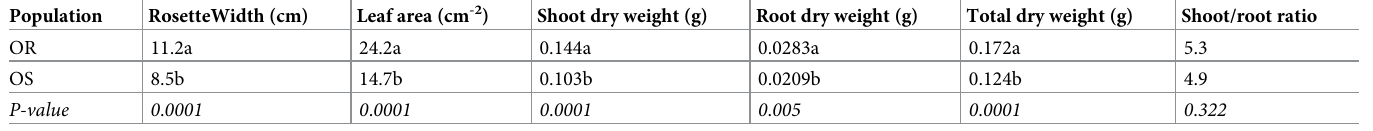
Mean values followed by different letters are significantly different between the two populations, according to t-tests (P <